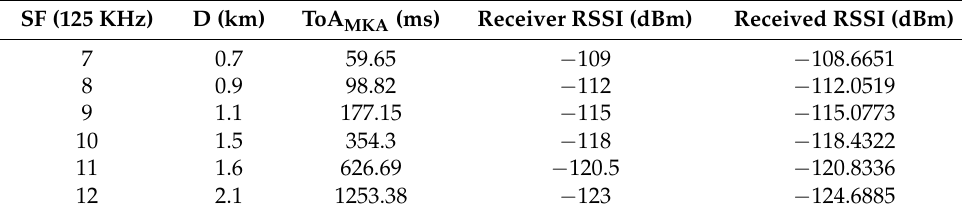
Table 4. Single gateway based on K-means